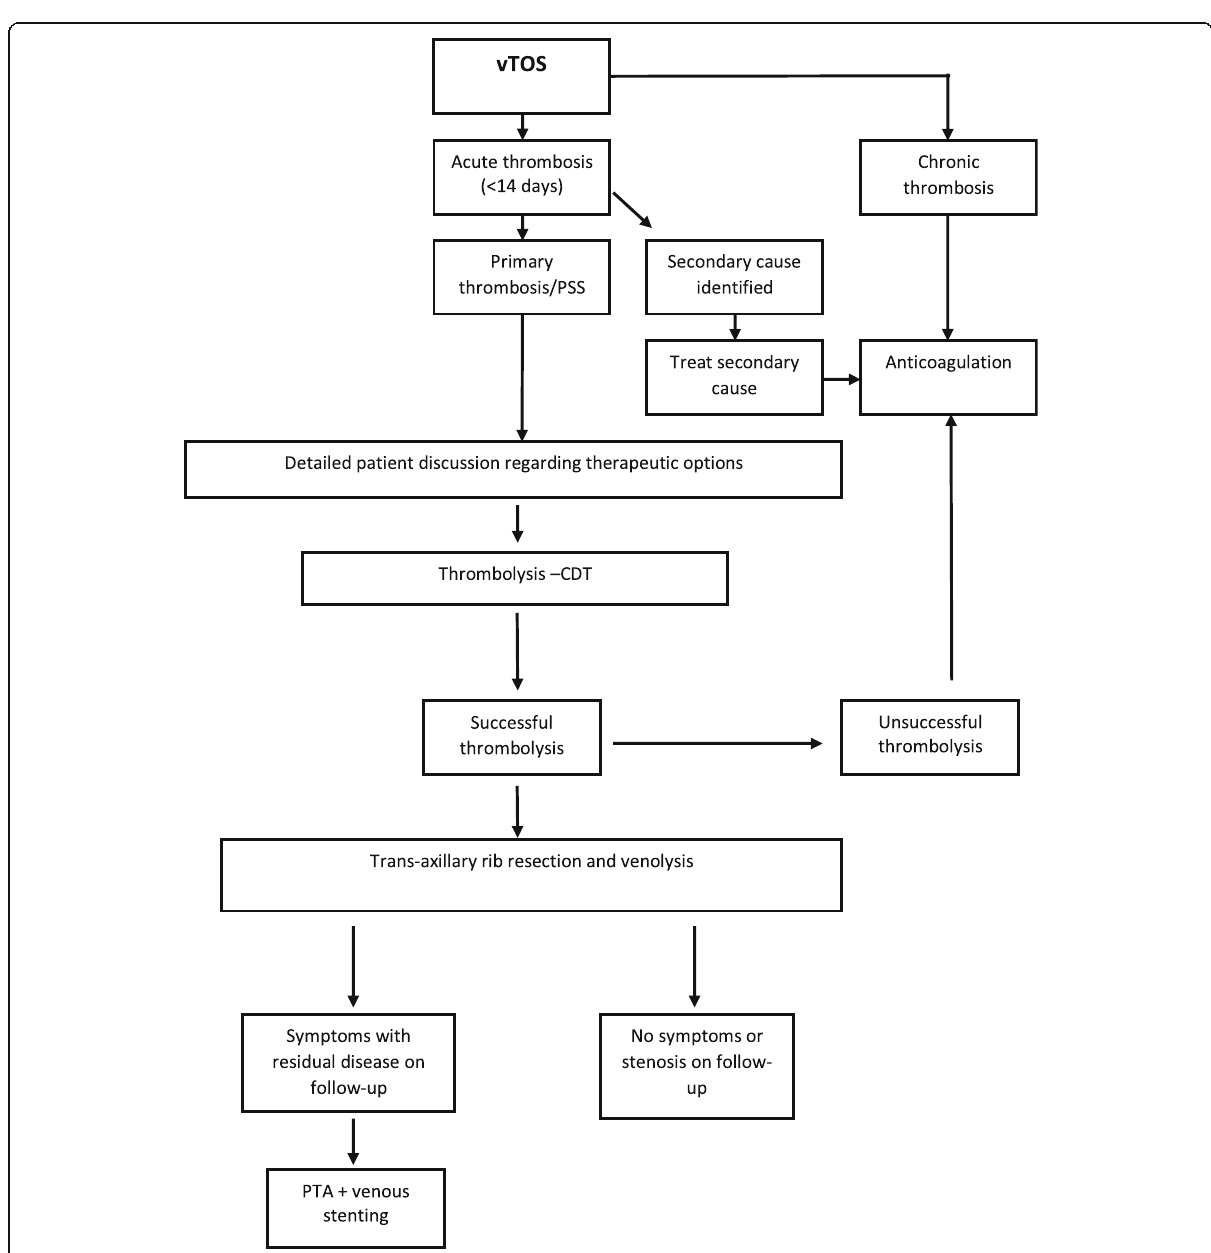
Fig. 1 Royal Prince Alfred Hospital treatment algorithm for venous thoracic outlet syndrome. vTOS, venous thoracic outlet syndrome; CDT, catheter-directed thrombolysis; PTA, percutaneous transluminal